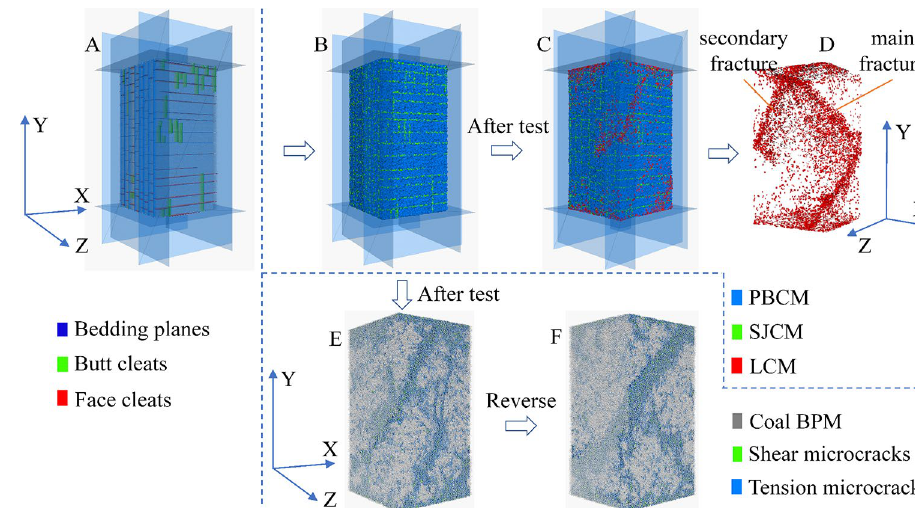
Fig. 9 Joint geometry and